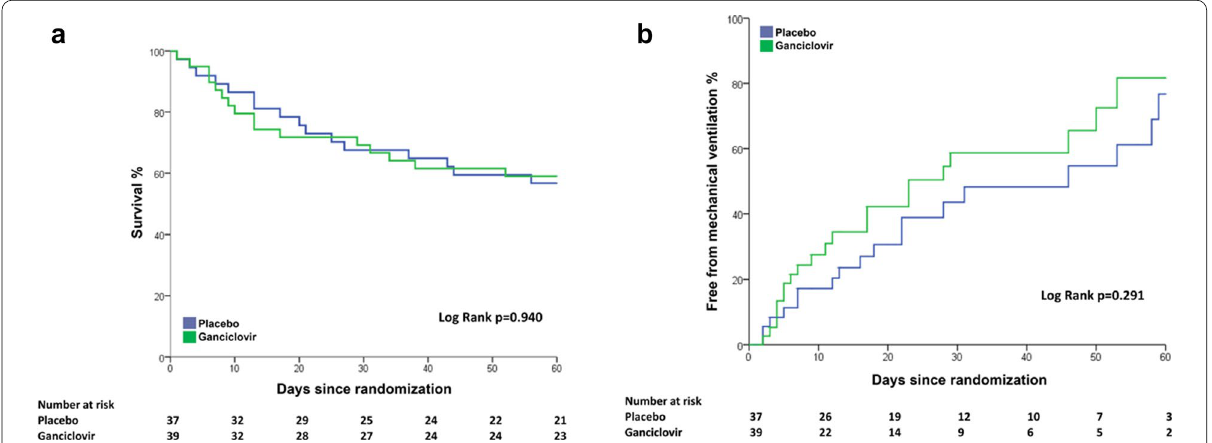
Fig. 2 a Survival curves. b Cumulative proportion of patients weaned from invasive mechanical